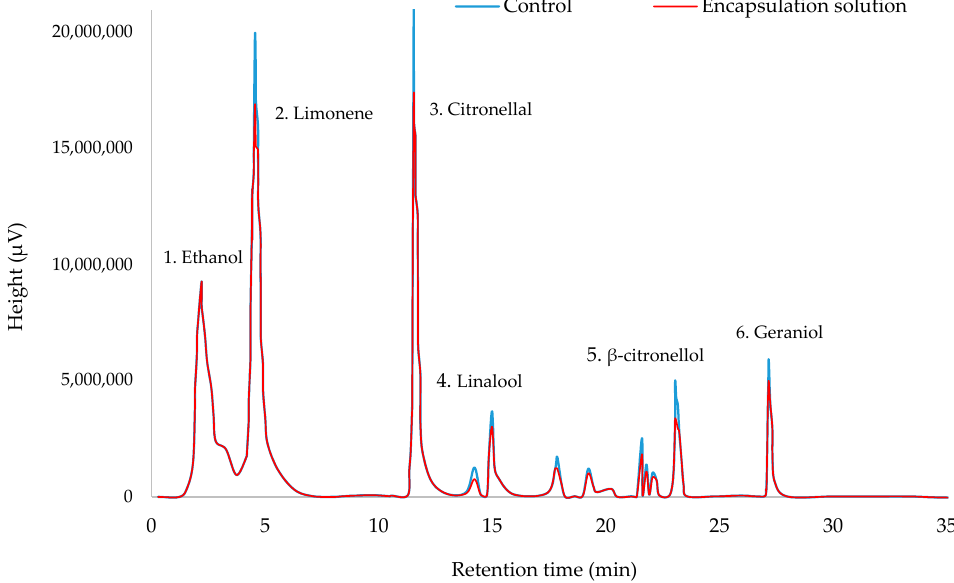
Figure 3. Overlaying of chromatographic analysis of free Java citronella EO (control) and Java citronella EO encapsulated within GD-PAMAM-2 under optimized conditions—(1) ethanol (sample solvent), (2) limonene, (3) citronellal, (4) linalool, (5) β -citronellol, (6) geraniol. Table 5. Chemical structures and calculated molecular volumes of the major compounds of cinnamon and Java citronella EOs; and their individual retention rate in the optimized encapsulation within dendrimers.